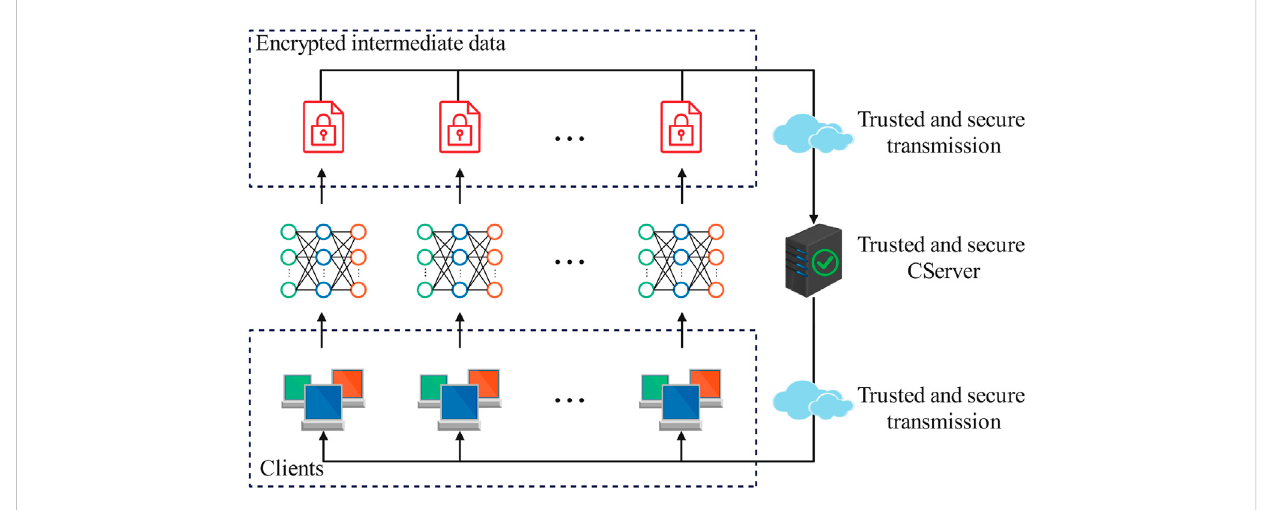
FIGURE 4 Federated learning based on homomorphic